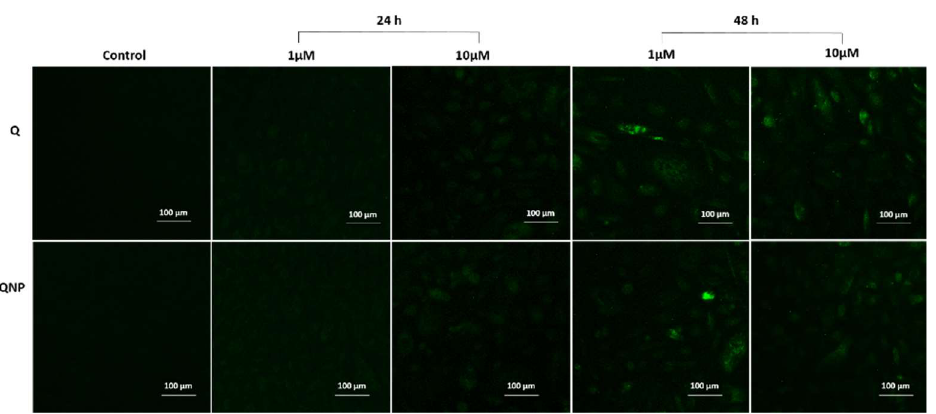
Figure 7. Fluorescence micrographs of Mito-tracker Red RMX-ros-stained HeLa cells treated with different concentrations of Q or QNPs for 48 h. Bright red color is indicative of live mitochondria.